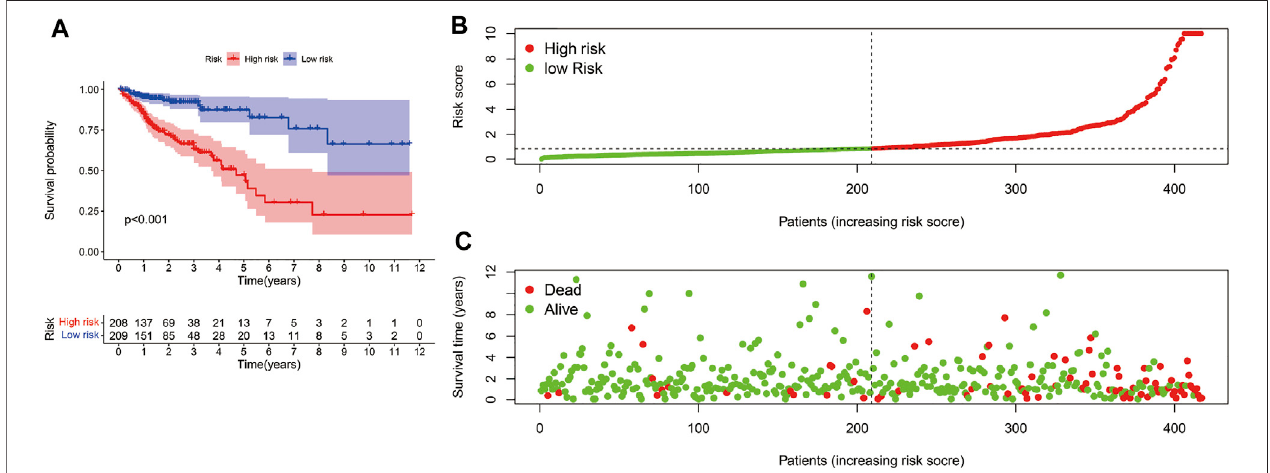
FIGURE 4 | Risk score model evaluation. (A) The K-M curve c omparison between the high-risk group and low-risk group. (B) The Risk curve of high-risk and low- risk group. (C) Patients ’ survival status